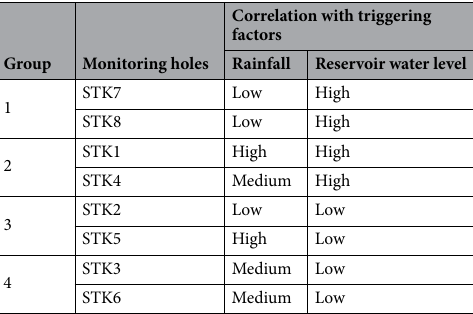
Table 1. Grouping of groundwater level monitoring holes.